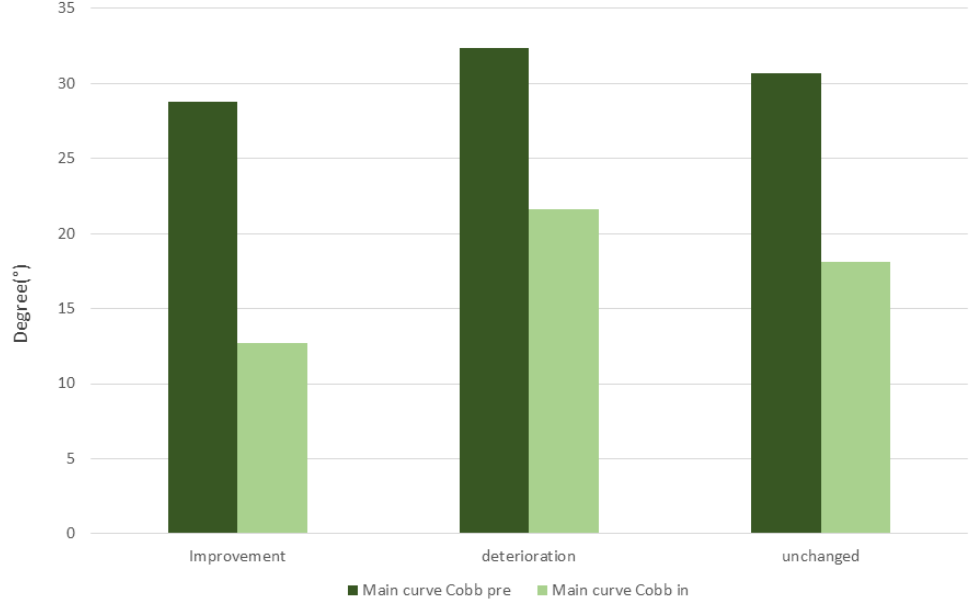
Figure 5. In-brace Cobb angle correction for group improvement, unchanged, and deterioration of primary Cobb angle at the end of C-Brace therapy.